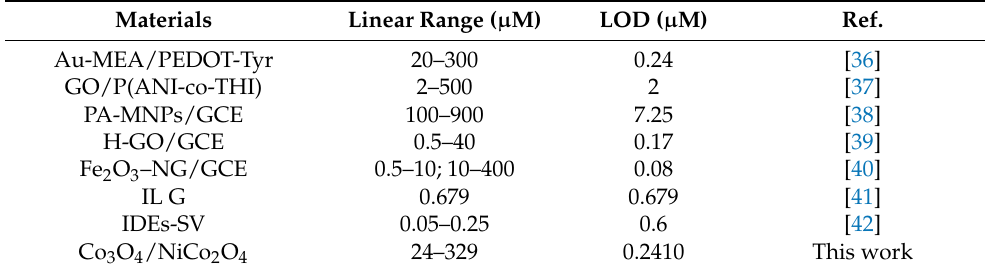
Table 2. Comparison of the performance of several different dopamine electrochemical sensors.